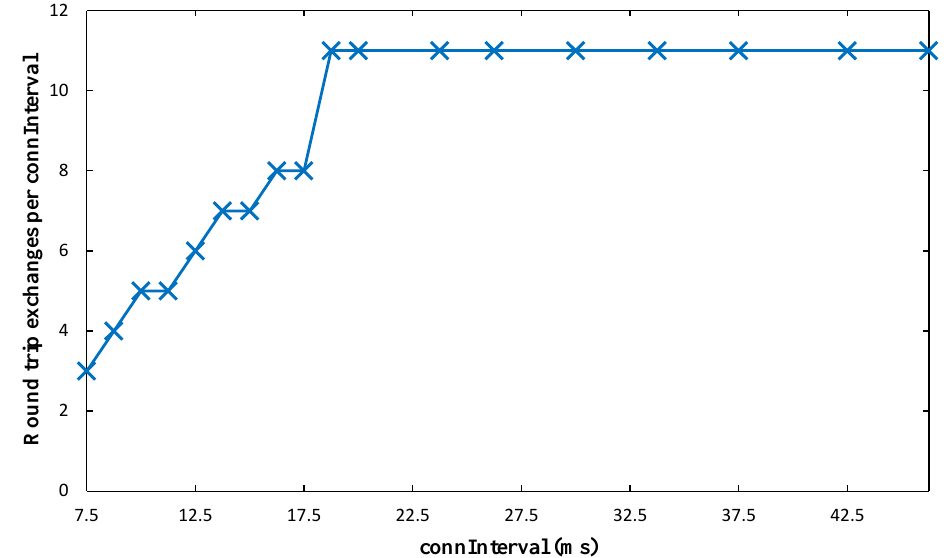
Figure 24. Number of round trip exchanges measured per connInterval , as a function of connInterval .